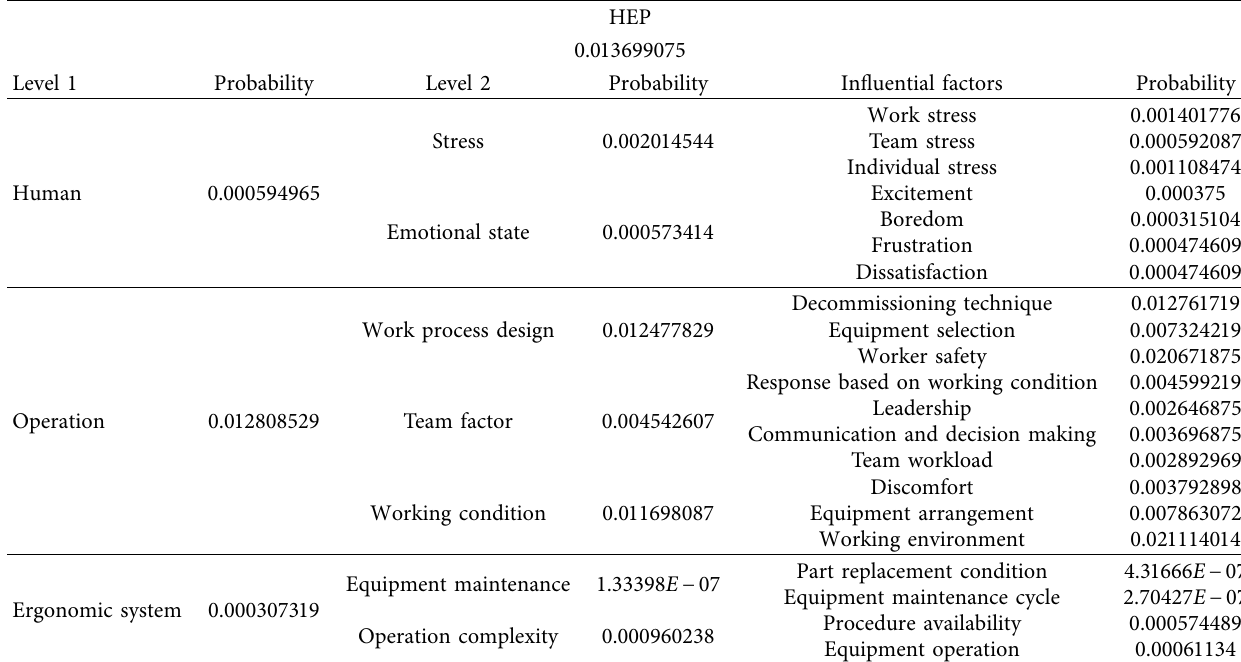
Table 5: HEP of NPP decommissioning activity and probability of each